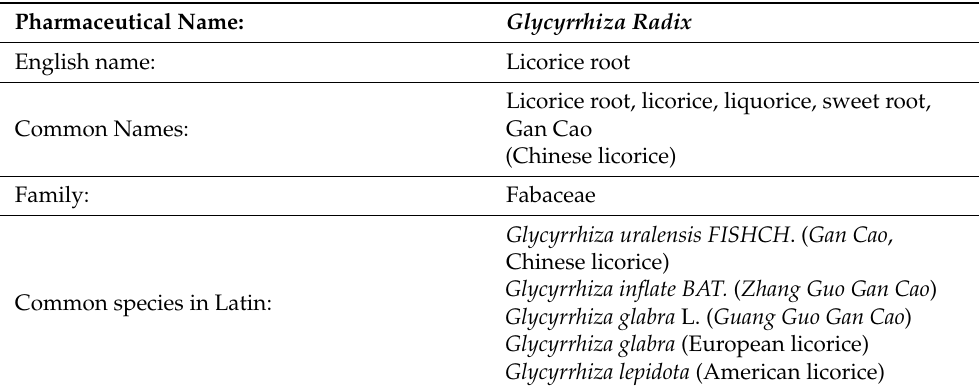
Table 1. Names and Classification of Glycyrrhiza Radix